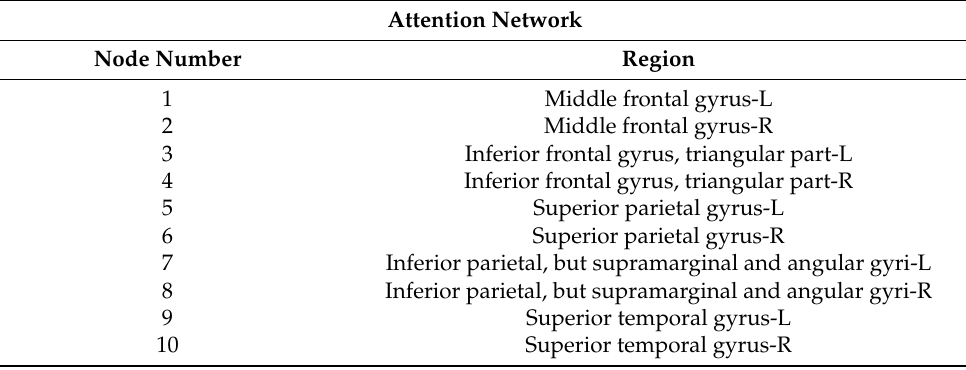
Table 4. ROIs of the ATN corresponding to the activity pattern in Figure